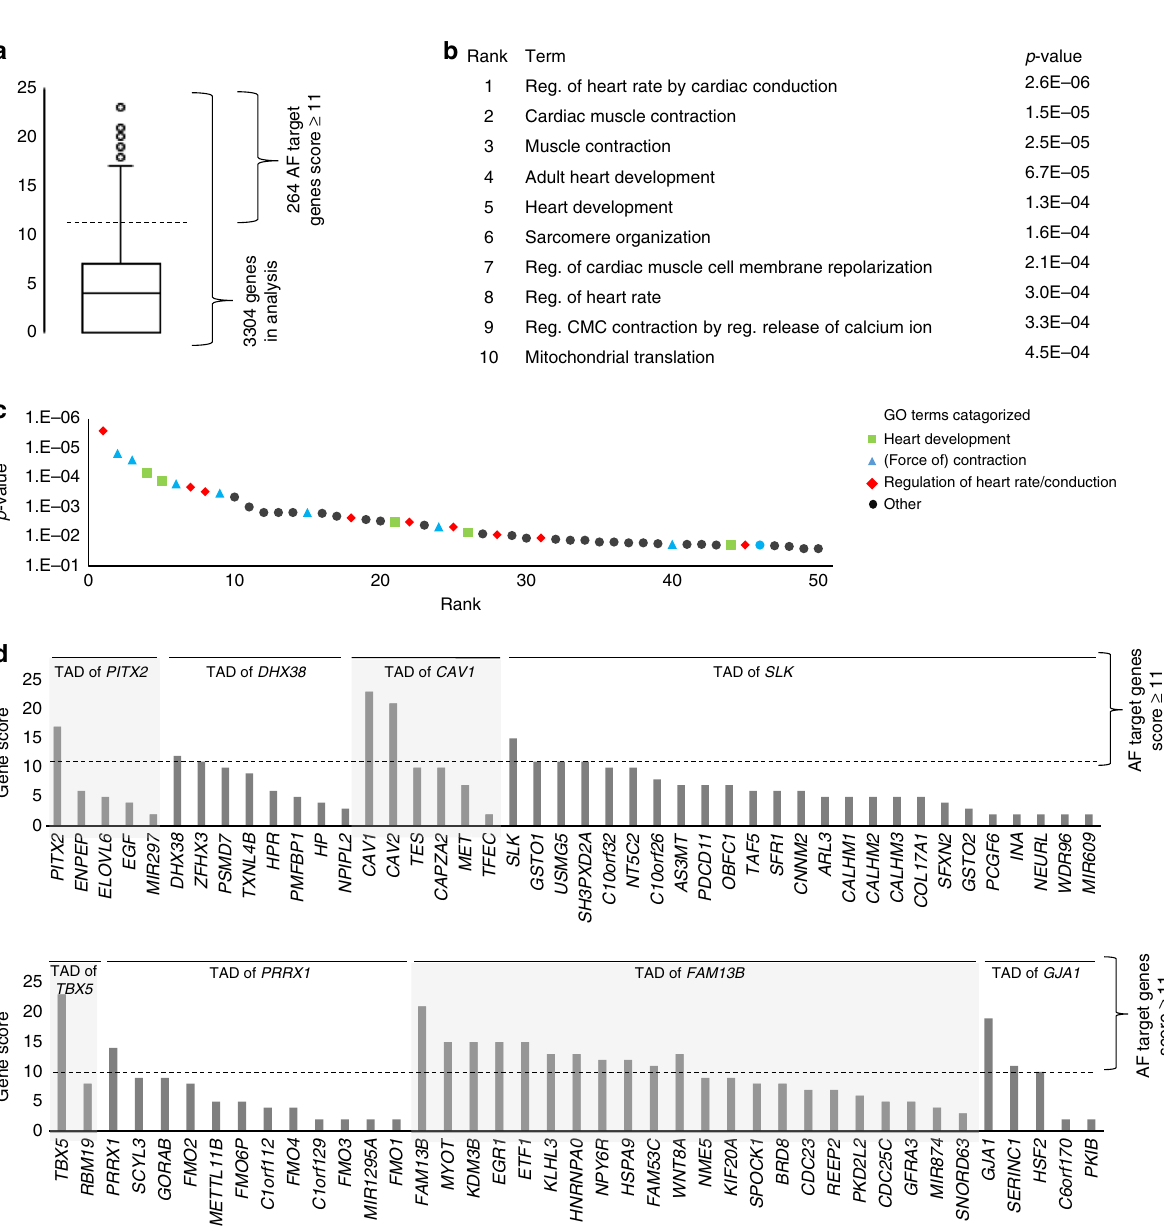
Fig. 2 Scoring and target genes. a Boxplot showing distribution of all genes included in this study. b Top 10 functional GO terms for all genes with score > 11 and p -value of enrichment. c Top 50 functional GO terms categorized. d Summary of potential AF target genes with a score > 11. Locus number, nearest gene, and target genes per locus are shown, with their scores. GO Gene ontology, AF atrial fi